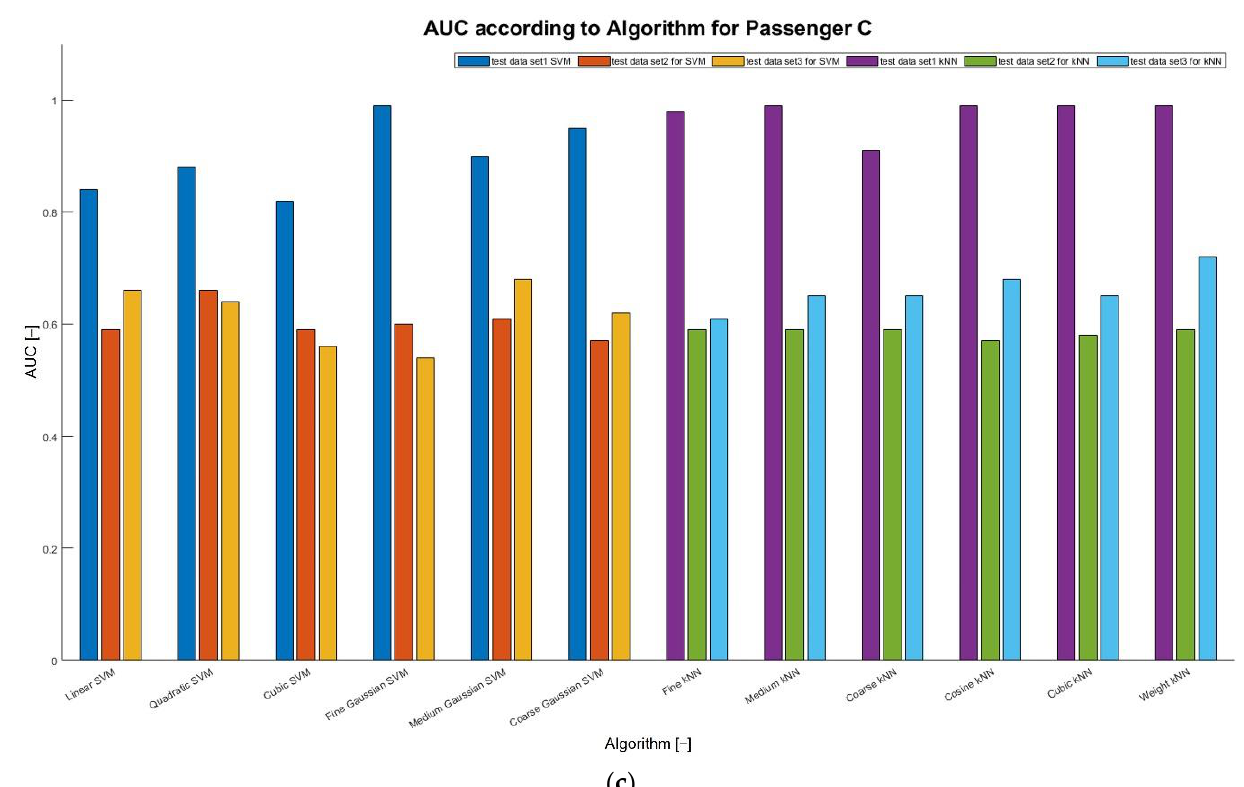
Figure 8. AUC of all passengers: ( a ) AUC of passenger A; ( b ) AUC of passenger B; and ( c ) AUC of passenger